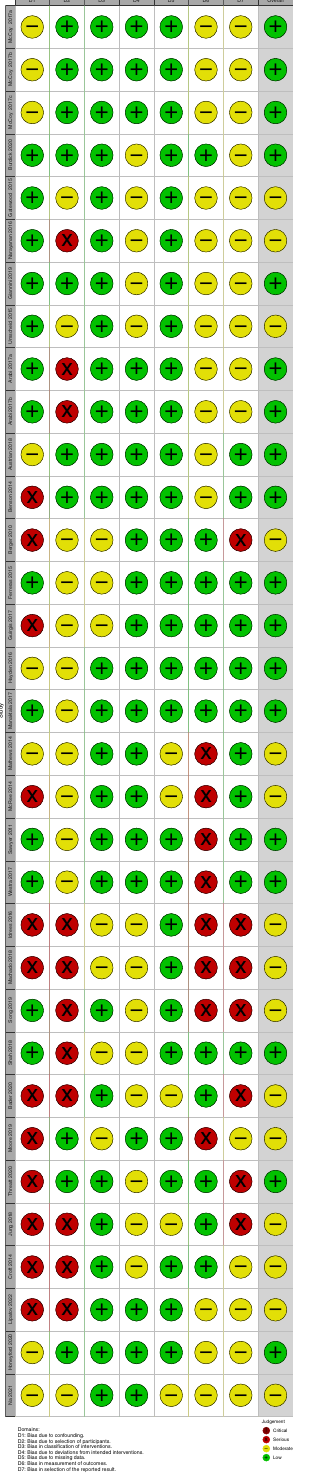
Fig. 3 Risk of bias assessment for each of the non-randomized studies. The rows represent the individual study and the columns represent the quality items as annotated at the